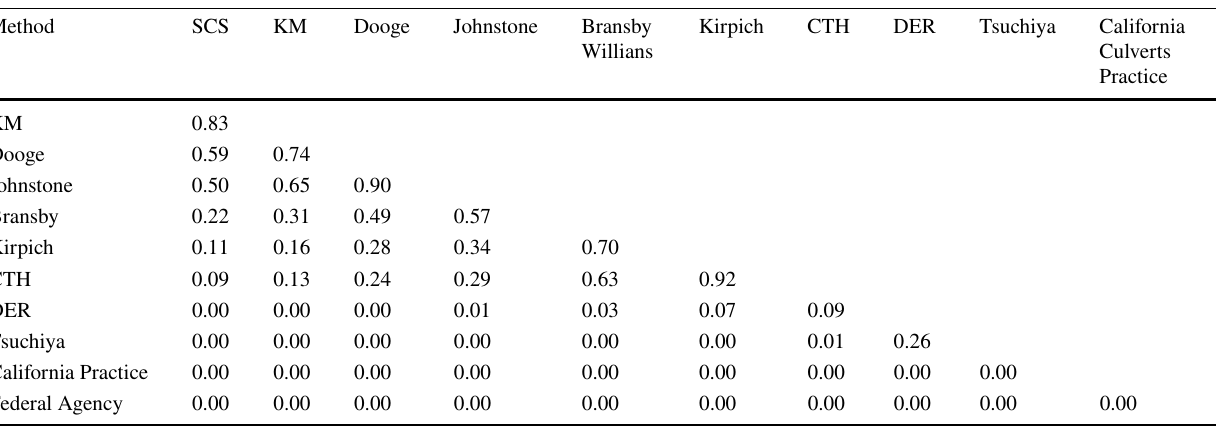
Table 7 Correlation between the Recurrence Period ( T ) and the concentration time ( tc ) methodologies, Ribeirão do Surú watershed, Santana do Parnaíba, SP,